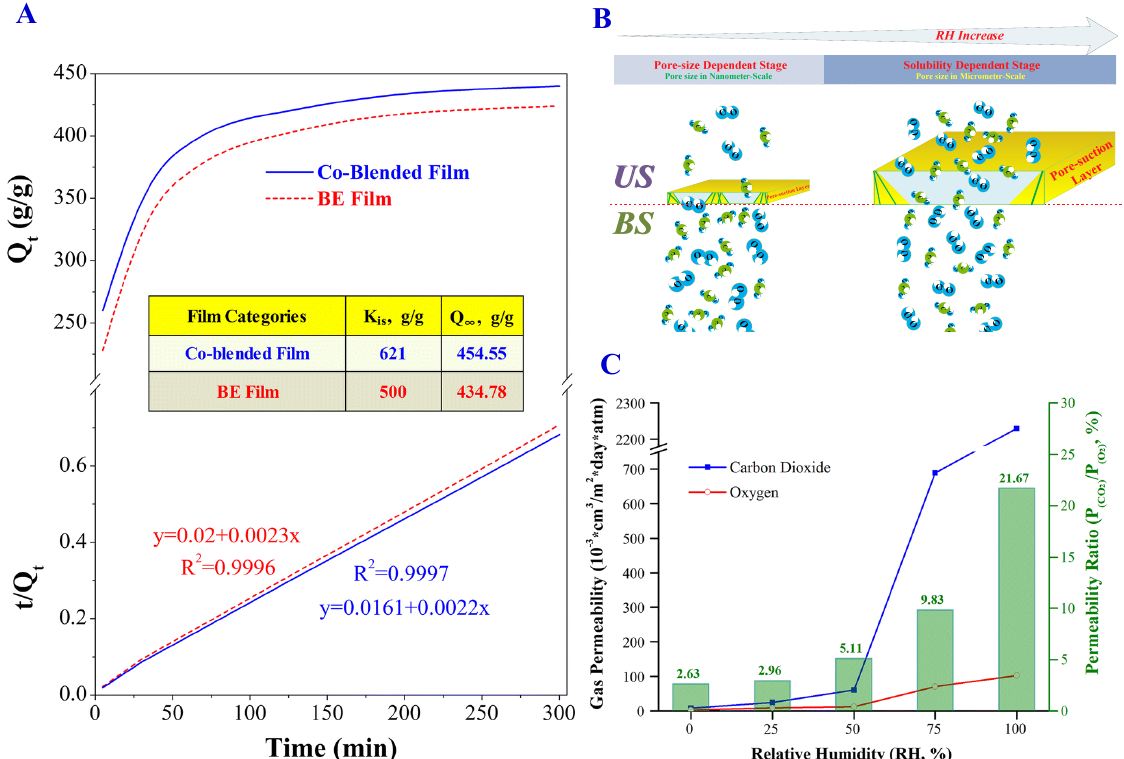
Figure 26. Swelling kinetics (Q t ) and linear plotting (t/Q t ) of BE film and co-blended film at different submerse time (t) (tests were conducted inside of distilled water at room temperature) ( A ), gas diffusion dynamic as the relative humidity (RH) increases ( B ), and effect of relative humidity (RH, %) on the gas permeability and gas selectivity of the BE film (Bottom Side, test was conducted at the temperature of 25 °C) ( C ) [9].